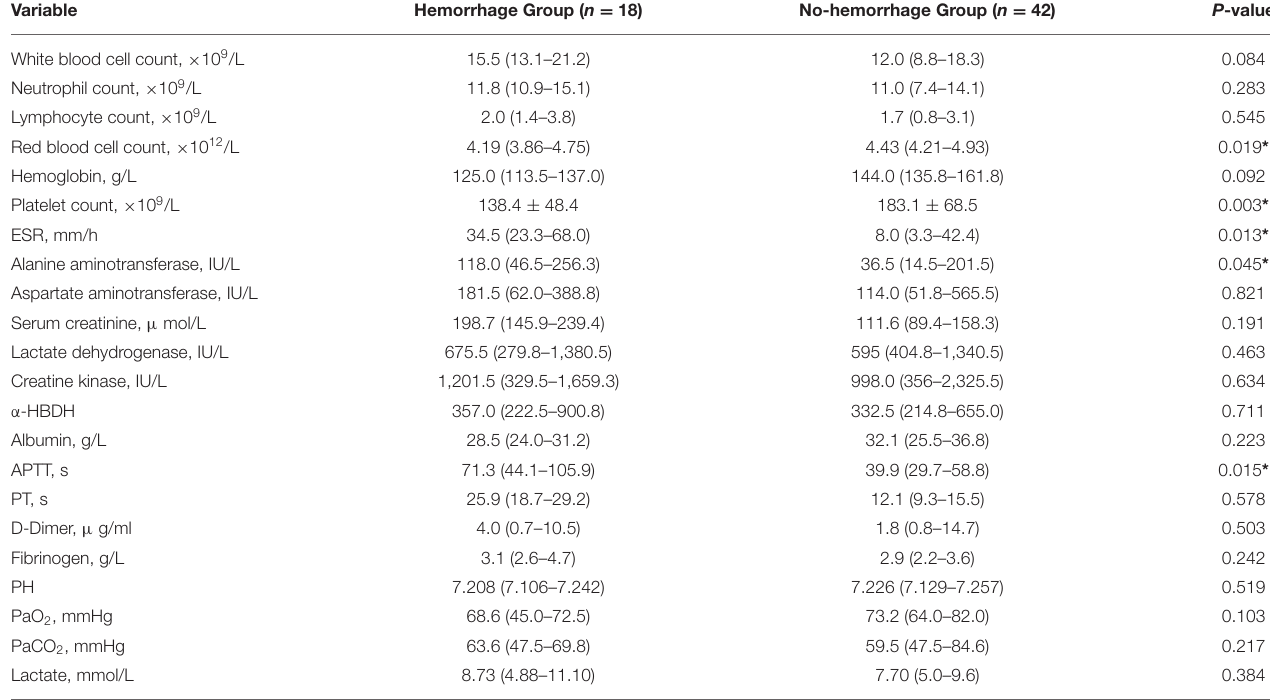
TABLE 3 | Laboratory characteristics of patients.